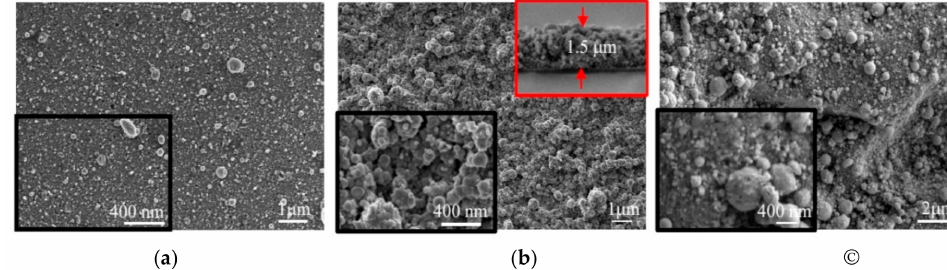
Figure 5. SEM images of MoS x ~2 + δ / Mo films obtained on the ( a ) Si, ( b ) SiO 2, and ( c ) glassy carbon (GC) substrates by on-axis PLD in Ar at a pressure of 8 Pa. The deposition times were ( a ) 4 min, ( b ) 64 min, and ( c ) 64 min. ( b ) The top inset shows a cross-sectional image of the